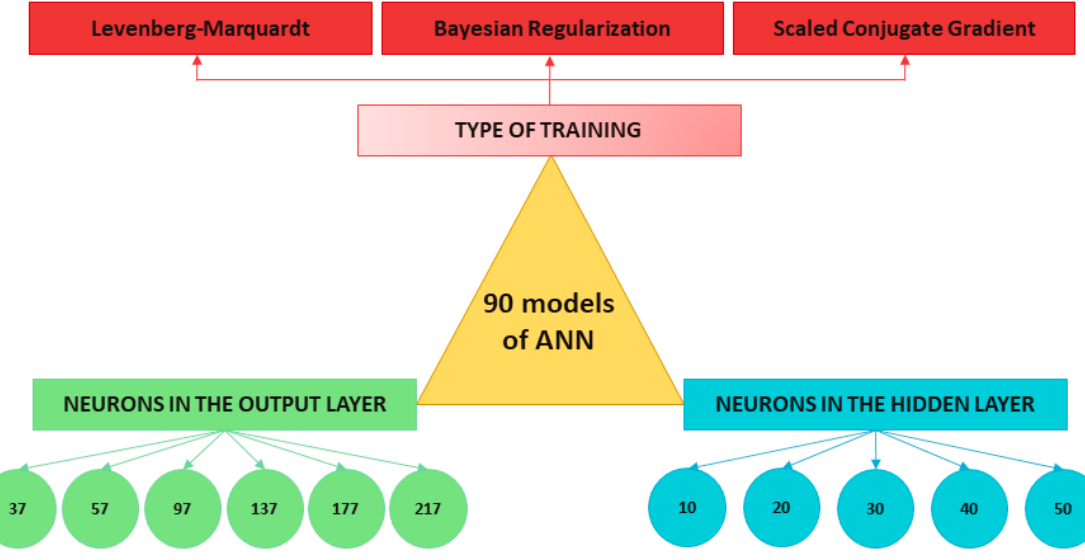
Figure 12. Design decisions for the development of ANN architectures.